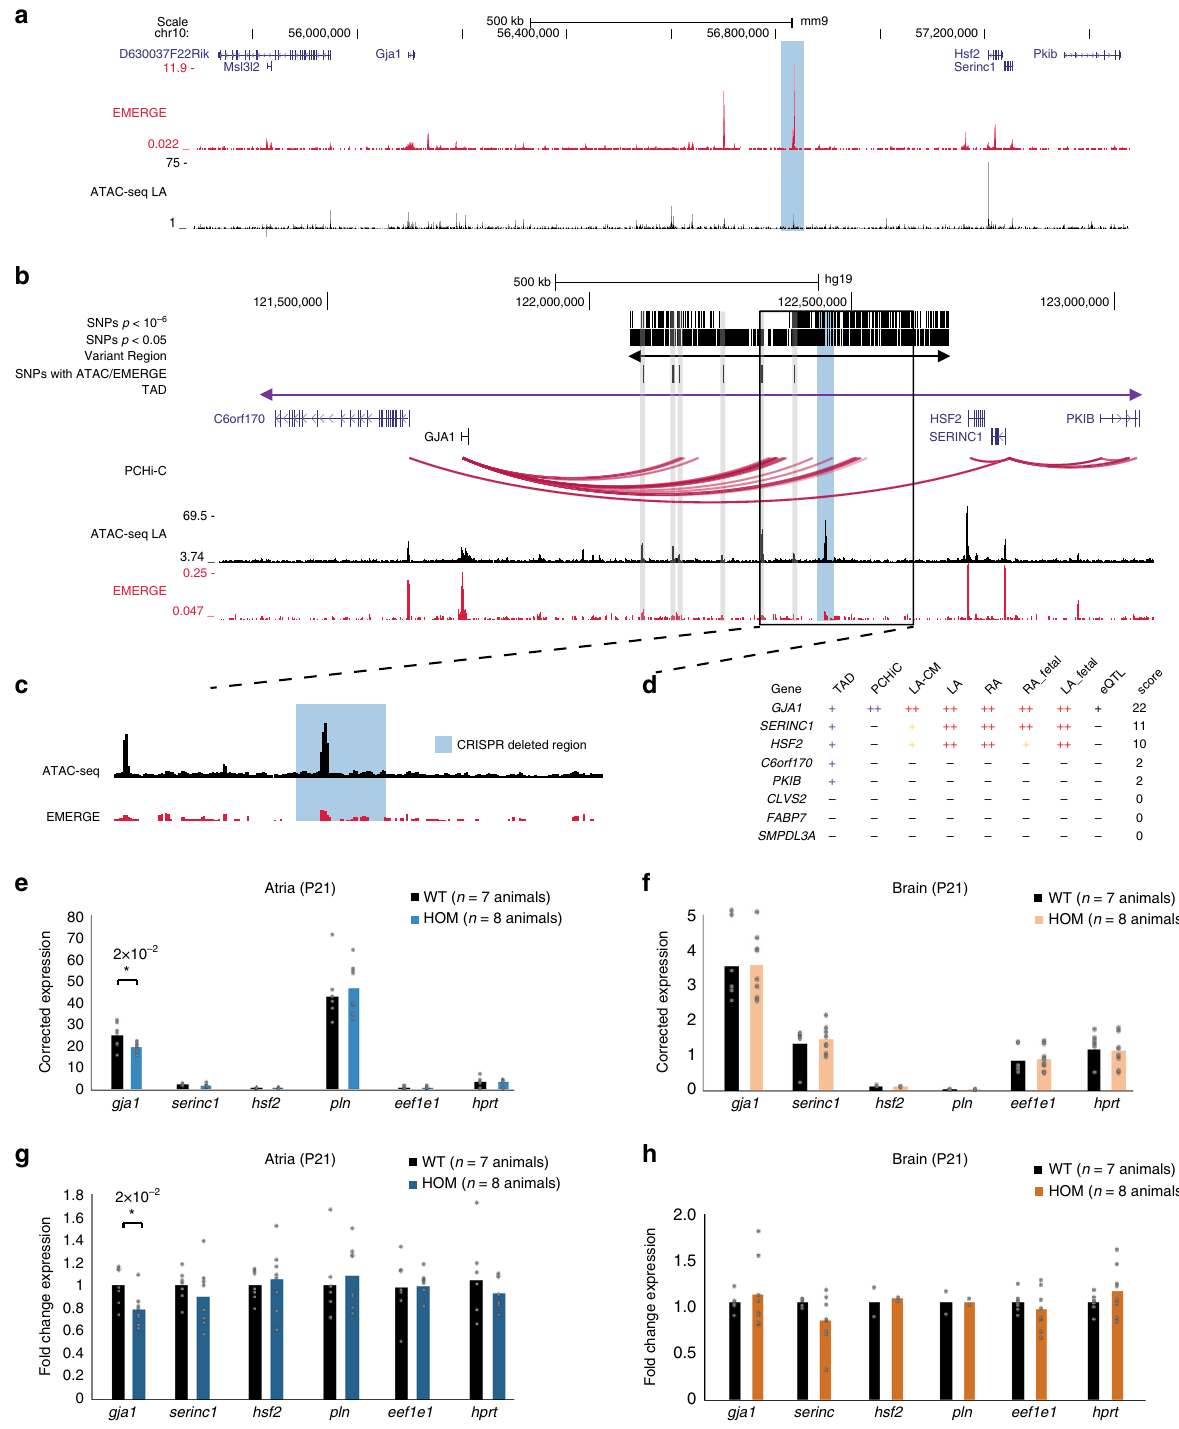
Fig. 5 Variant region deletion shows distal regulatory element downstream of Gja1 in mouse. a Mouse region homologous to human AF associated GJA1 locus, showing gene, EMERGE and ATAC-seq tracks. Highlighted region is the 40 Kb deletion. b Browser view of human GJA1 locus, showing AF associated (subthreshold) SNPs in variant region (VR), TAD, genes, cardiac PCHi-C, ATAC-seq and EMERGE. Human homologous deleted region (highlighted). c Zoom of the human homologous deleted region (highlighted.) d Expression and PCHi-C values per gene in the TAD. e Corrected expression of genes as assessed by qPCR with Hprt and Eef1e1 as reference genes in atria and f brain. g Expression fold change of Gja1 RE1/RE1 (HOM) vs wild-type (WT) littermates as a negative control of P21 atria and h brain cortex. Source data of 5 e – h are provided as Source Data fi les. Error bars represent SD, * p < 0.05, ** p < 0.01, and *** p < 0.001 (two-tailed Student ’ s t -test). kb kilobase, SNP single nucleotide polymorphism, TAD topologically associated domain, PCHi-C